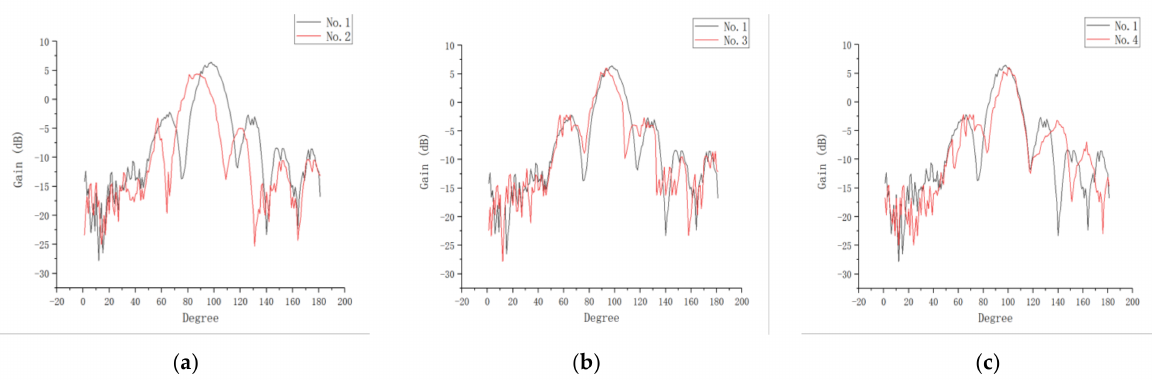
Figure 12. Measurements of the influence of the improved structure on antenna performance: ( a ) Antenna one and antenna two; ( b ) antenna one and antenna three; ( c ) antenna one and antenna four.